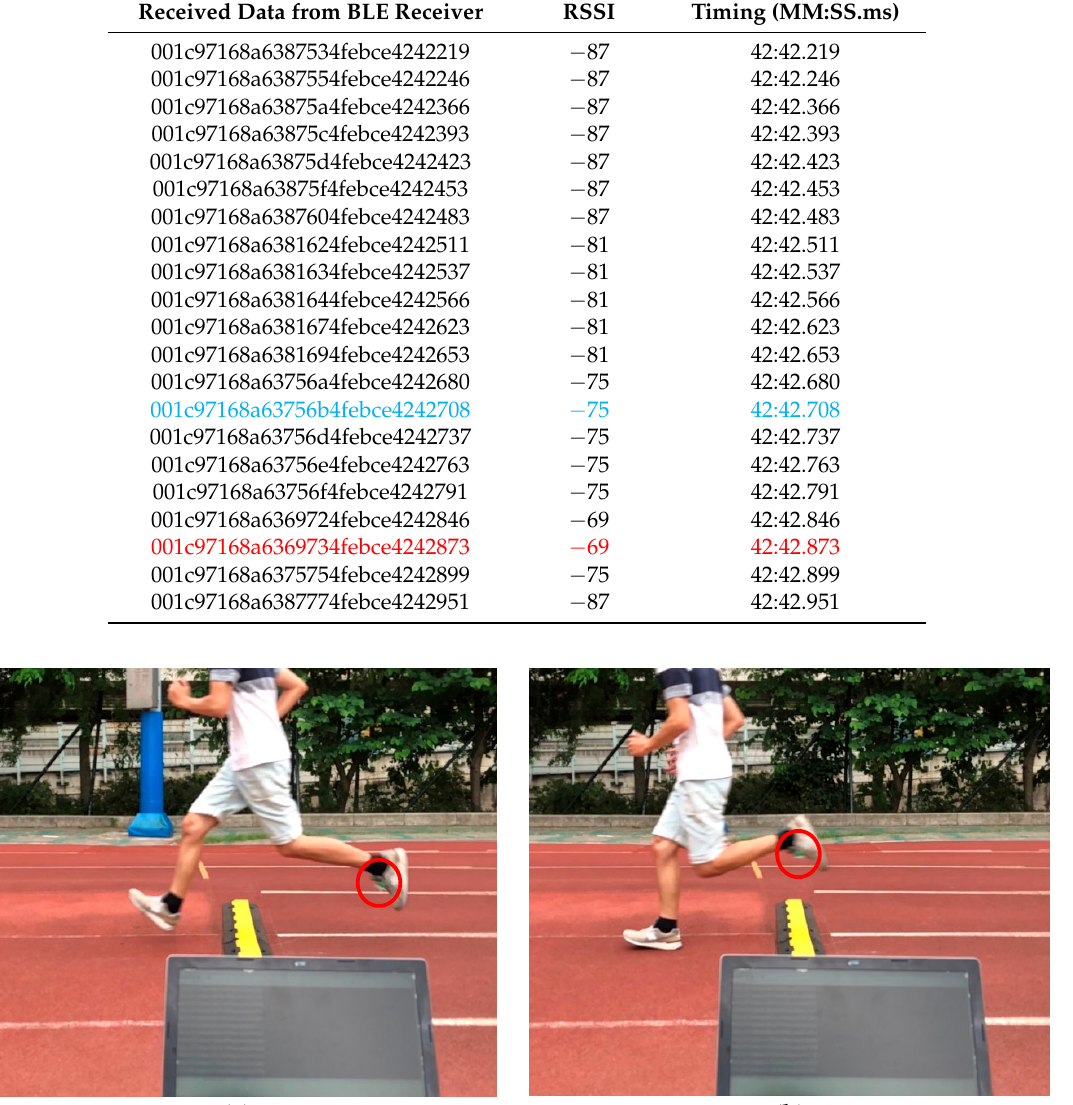
Table 6. One dynamic experiment in which the BLE Tag was on the chest.